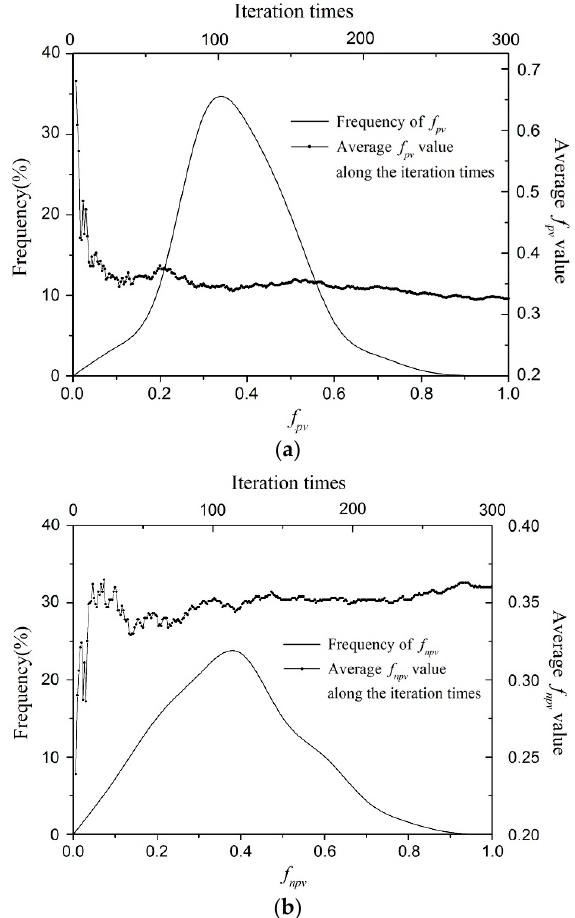
Figure 6. f pv ( a ); and f npv ( b ) distribution and their average values relative to unmixing iterations using Automated Monte Carlo Unmixing Analysis (AutoMCU).